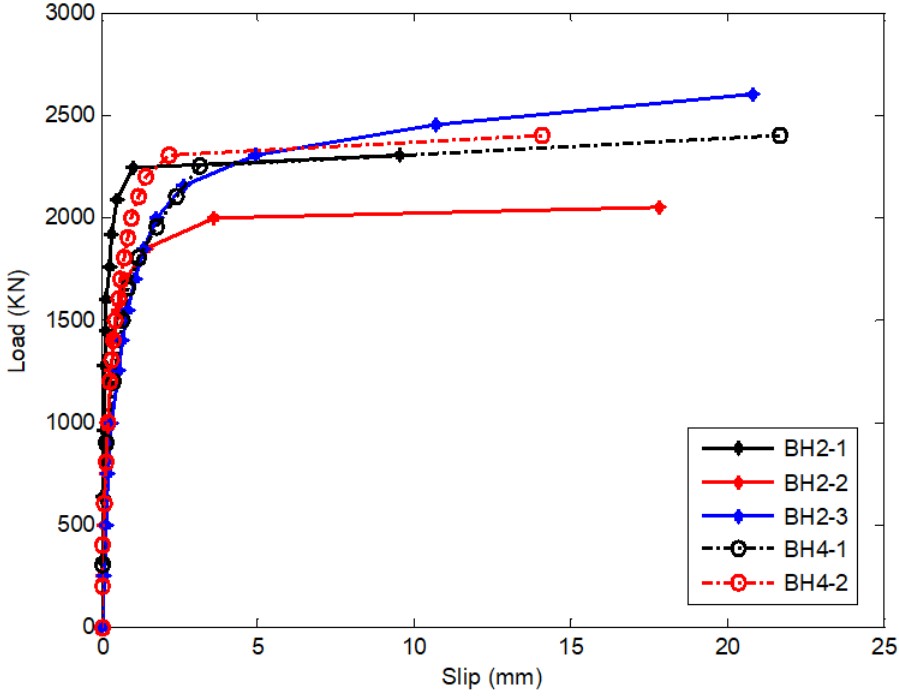
Figure 9. Load – slip relationship. Figure 9. Load–slip